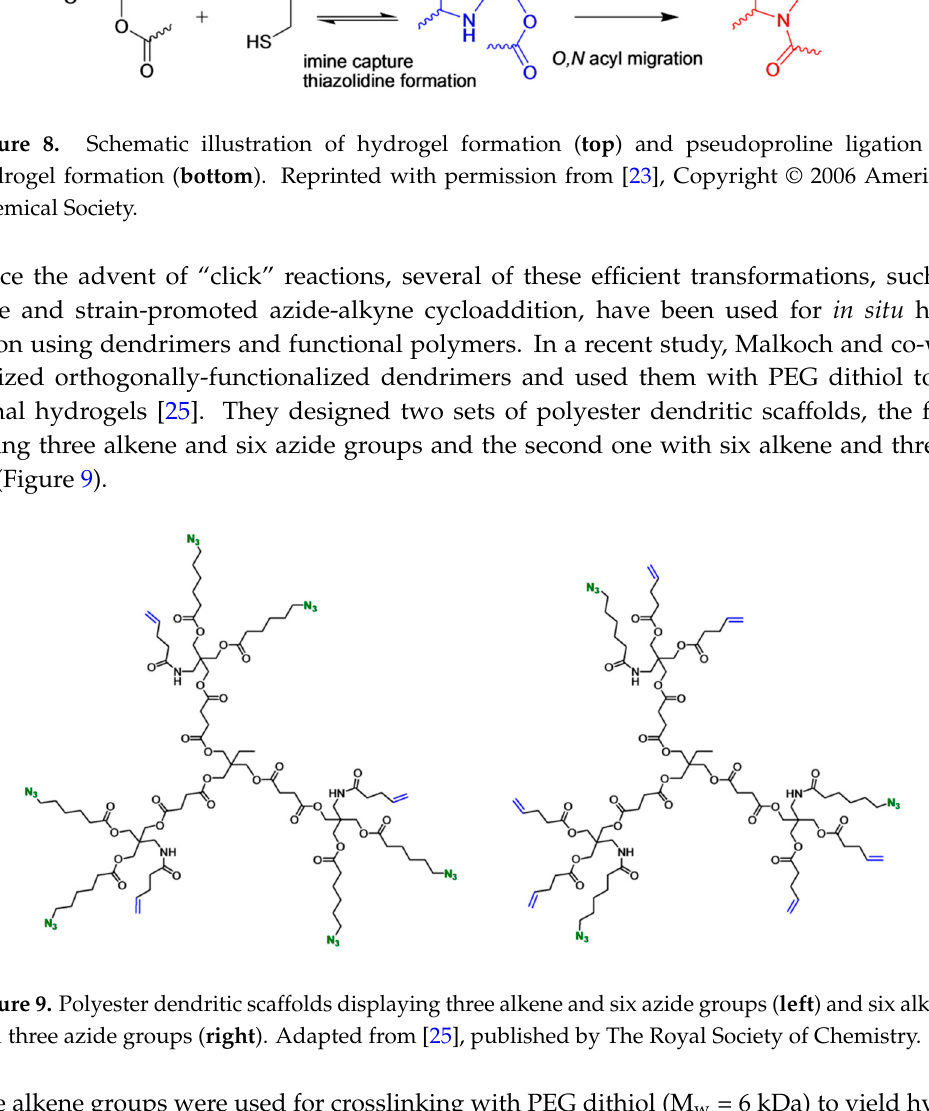
Figure 8. Schematic illustration of hydrogel formation ( top ) and pseudoproline ligation for hydrogel formation ( bottom ). Reprinted with permission from [23], Copyright © 2006 American Chemical Society.